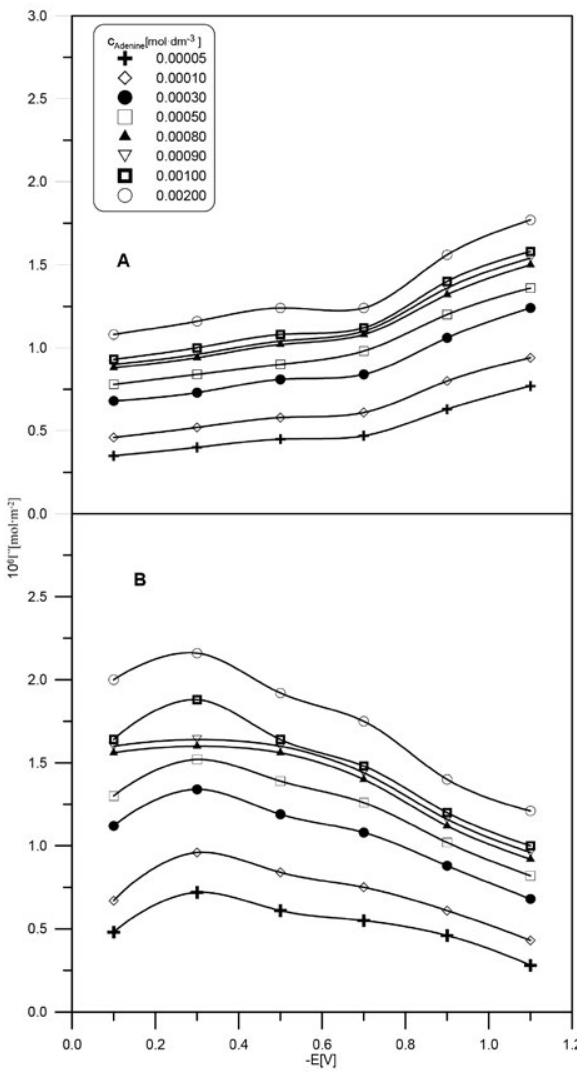
Figure 5. Relative surface excess of adenine as a function of the poten- tial and adenine concentration in the bulk, in the acetic buffers pH 3 (A) and pH